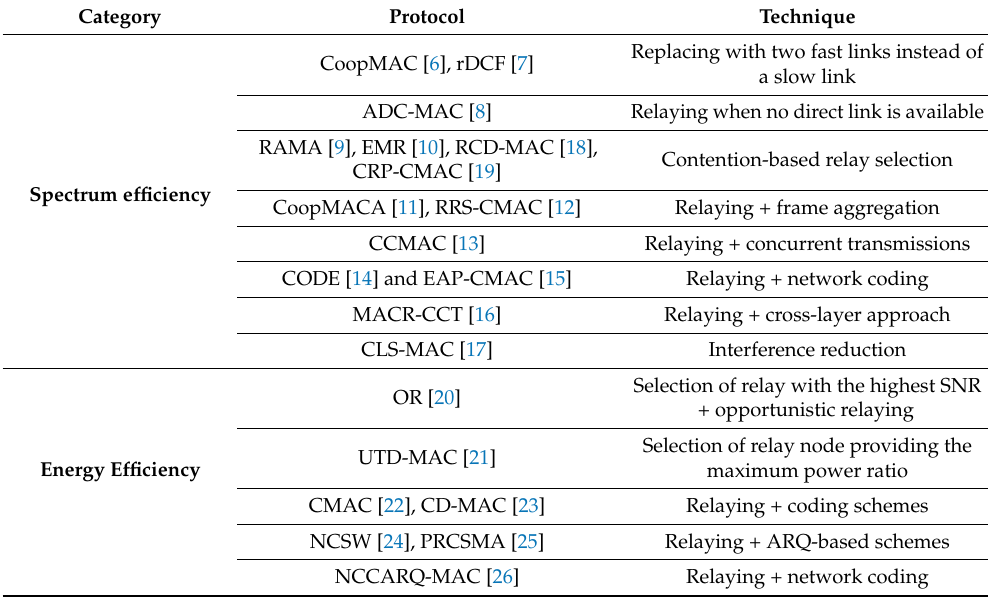
Table 1. Summary of existing cooperative medium access control (MAC) protocols in the IEEE 802.11 standard.